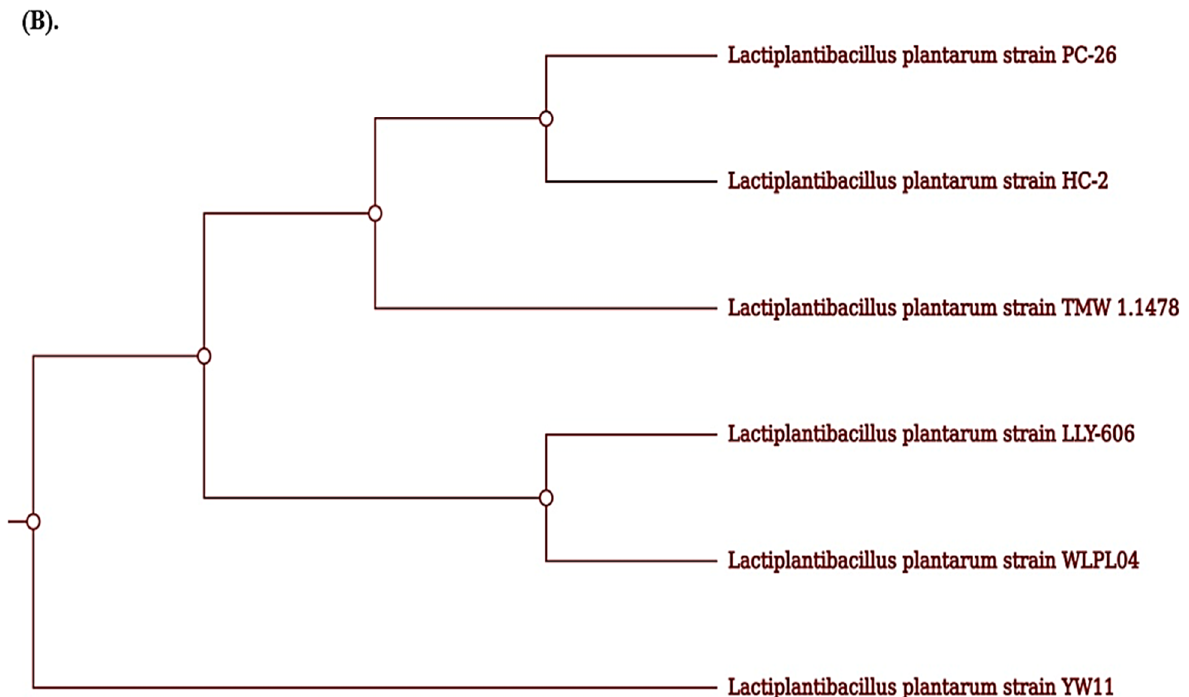
Figure 8. ( A ) Collinearity relationship of Lp YW11 with HC-2, LLY-606, pc-26, TMW, and WLPL04 showing aligned EPS-producing genes (Pink), transporter genes (Blue), regulatory genes (Green). ( B ) Phylogenetic Analysis of Lp YW11 with HC-2, LLY-606, pc-26, TMW and WLPL04.